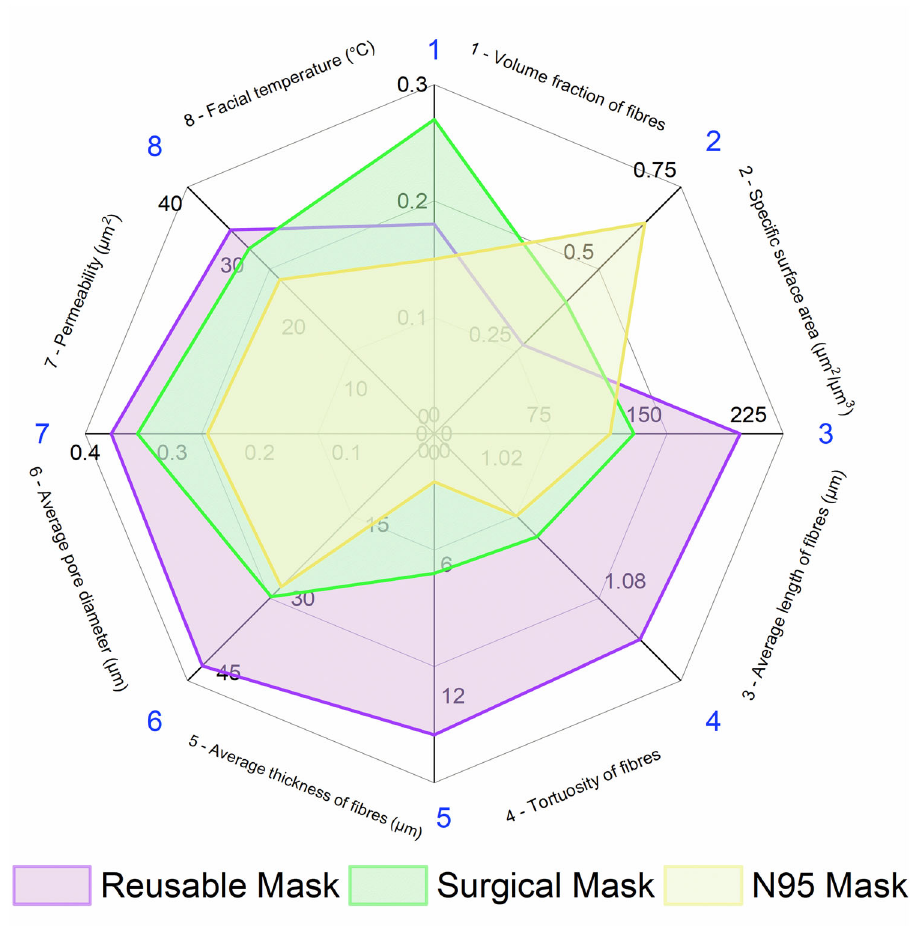
Fig. 6 The comparison of the microstructures and performance of the three face masks. The reusable mask has the best breathability and comfortableness (the highest facial temperature, coarse fi bres and the largest pore size within fi bre spacing) whereas the N95 mask provides the best aerosol fi ltration (the smallest pore volume, the fi nest fi bres and the largest speci fi c surface (Fig. 5) agree well with droplet fl ow simulation (Fig. 4), pro- viding an approach to correlate microscale structure with mesoscale performance.